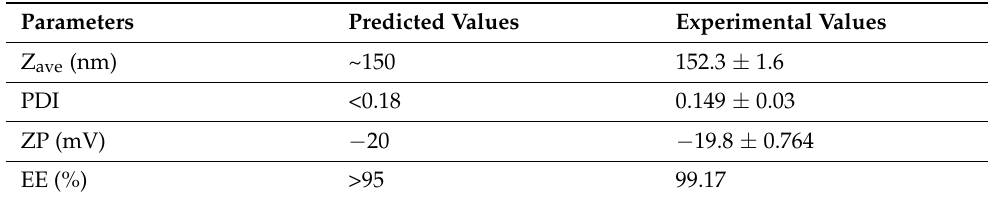
Table 4. Predicted and expected physiochemical parameters and EE of DXI-NLC. Parameters Predicted Values Experimental